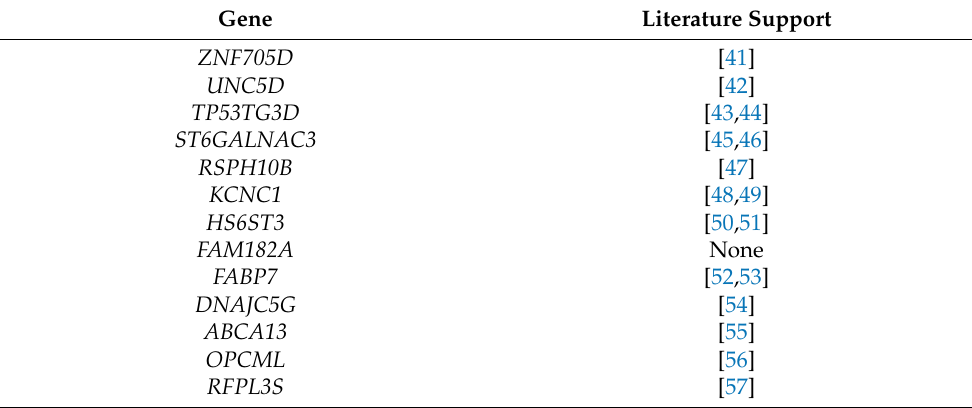
Table 1. Top Risk Increasing Genes Identified by TCGA-COAD Cox model: List of the top risk increasing genes identified by our Cox model on the TCGA-COAD dataset.